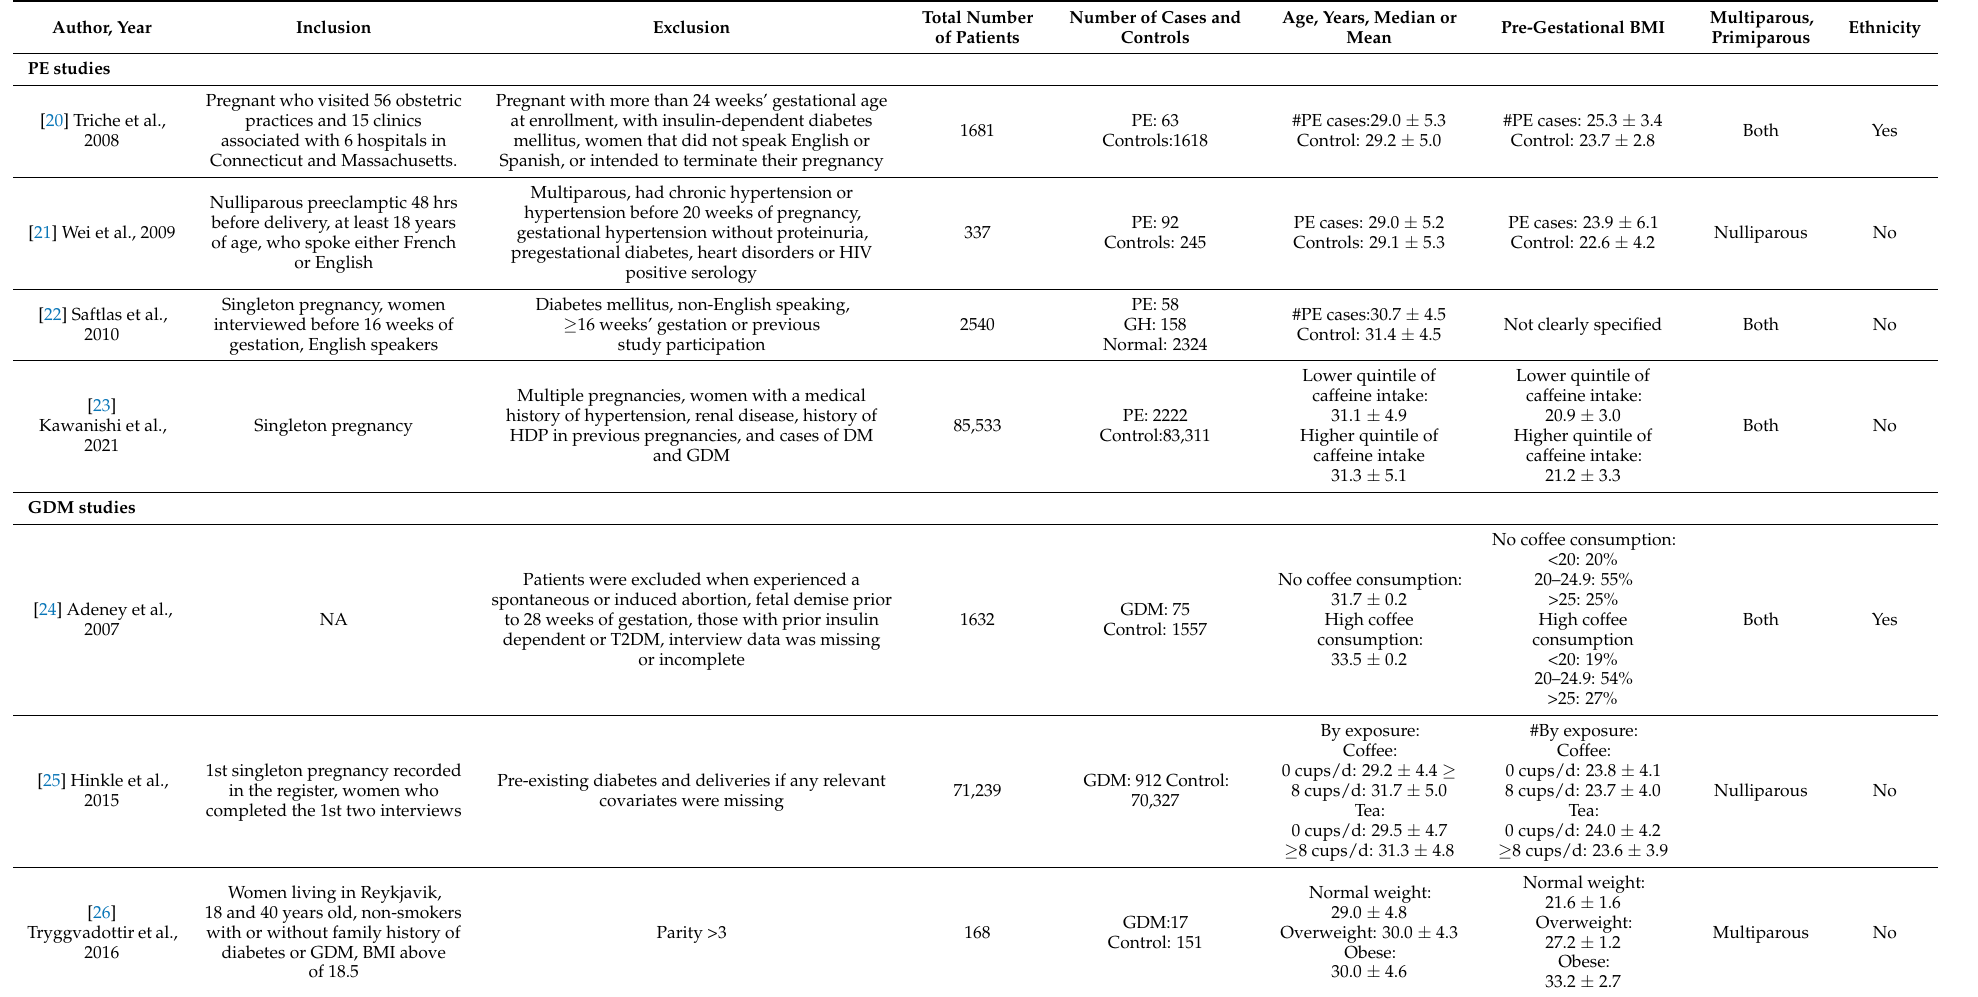
Table 2. Participant characteristics for studies included in the